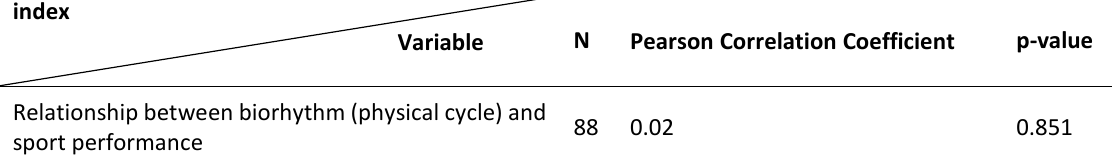
Table 1. Relationship between biorhythm (physical cycle) and sport performance index Variable Pearson Correlation Coefficient Relationship between biorhythm (physical cycle) and